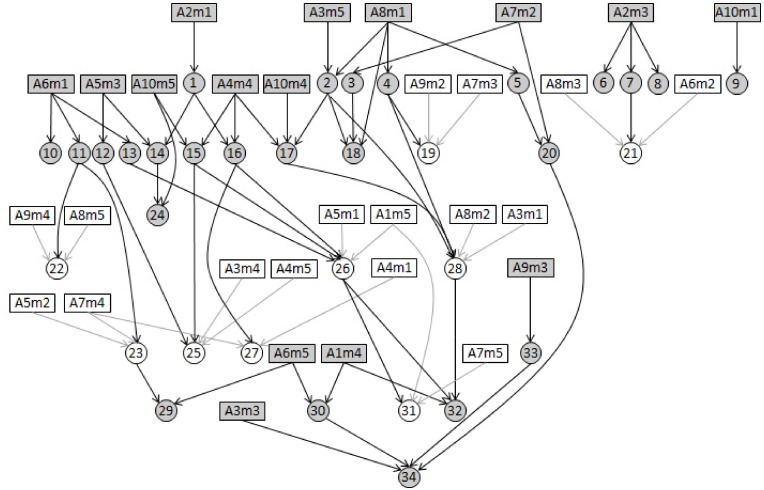
A synthetic QTL-phenotype network.This network consists of 31 QTLs, 34 traits and 74 directed edges. Traits are ordered by numerical numbers and QTLs are labelled in the form of ‘Cimj’ indicating the j-th marker on the i-th chromosome. Because only a part of QTLs were used in a third set of simulations, the nodes are further classified as follows: shaded rectangular nodes–QTLs present in the third set of simulations; clear rectangular nodes–QTLs absent in the third set of simulations; shaded circular nodes–traits provided with QTLs in the third set of simulations; clear circular nodes–traits provided without QTLs in the third set of simulations.